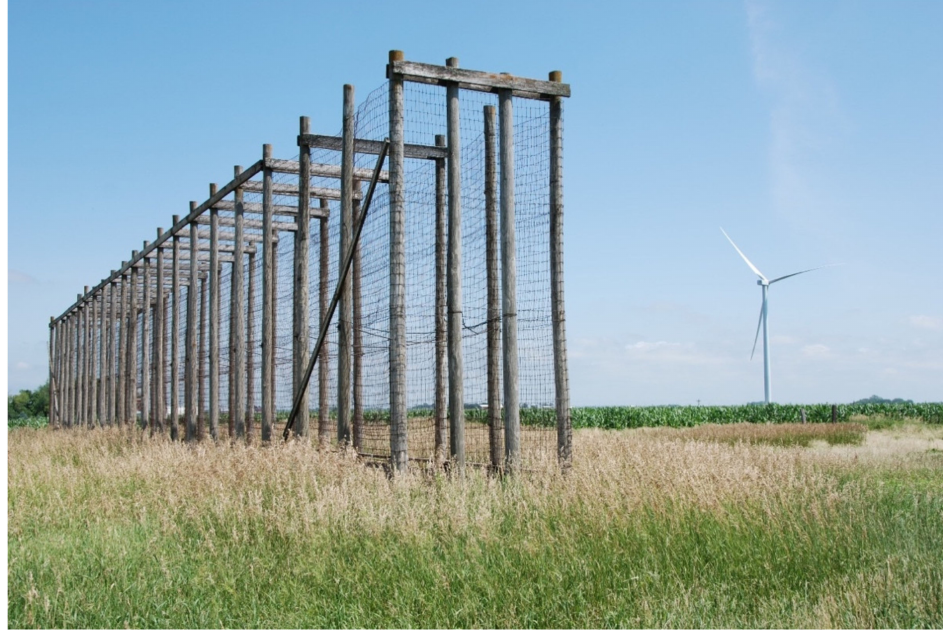
Figure 9. From transect across Northwest Iowa. Stage 5–Renaissance or Revival. Wind turbines and an abandoned corn crib north of